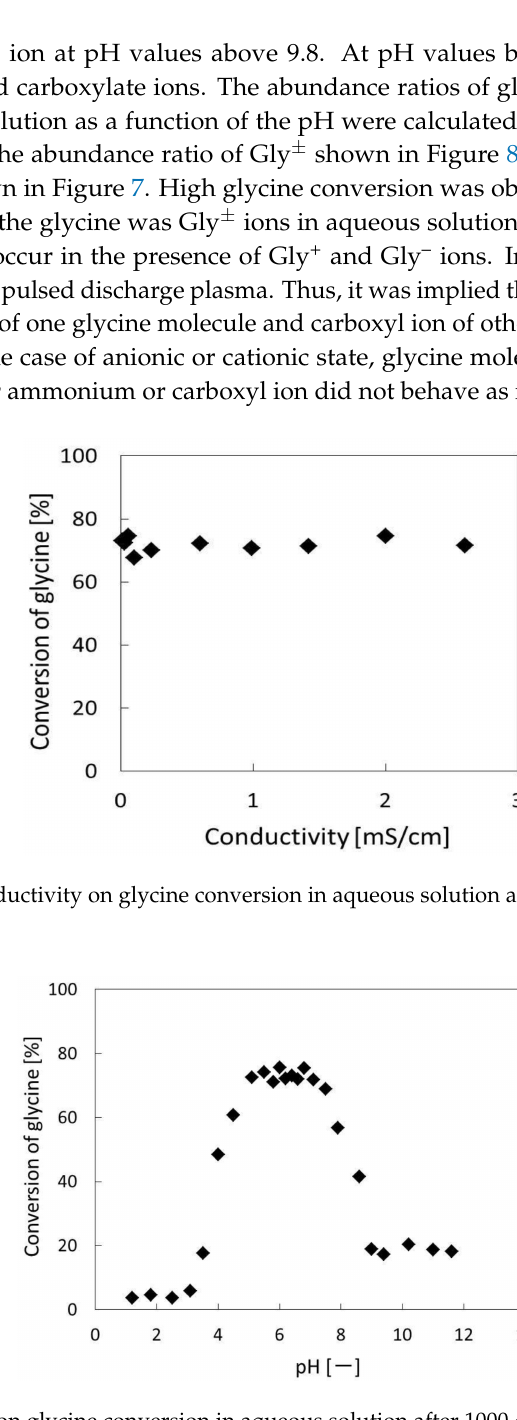
Figure 7. Effect of pH on glycine conversion in aqueous solution after 1000 discharge plasma pulses at 18.6